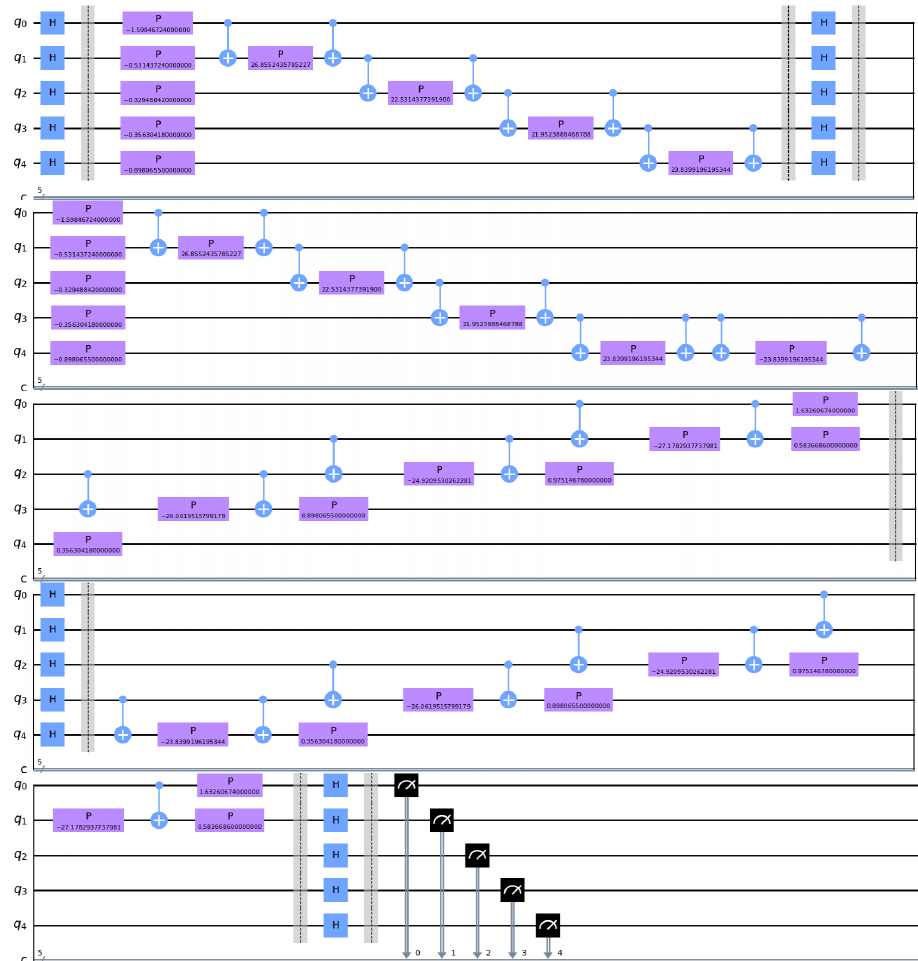
Figure 7. Schematic diagram of analog